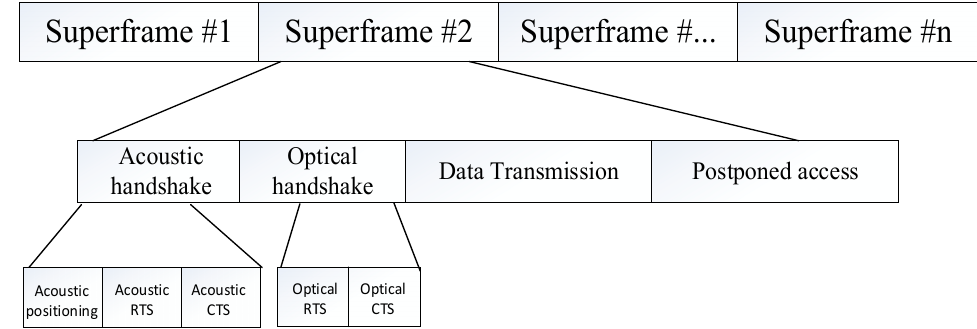
Figure 2. Superframe structure.